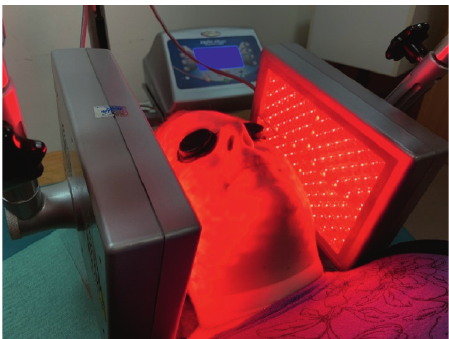
Figure 1: MLT treatment using LED panels (author’s photo).